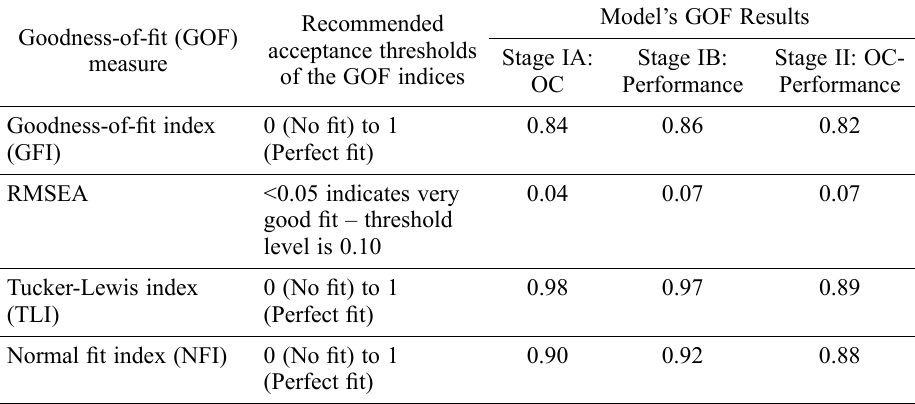
Table 3. Goodness-of-fit (GOF) measures recommended levels and results (table format adopted from Molenaar et al.